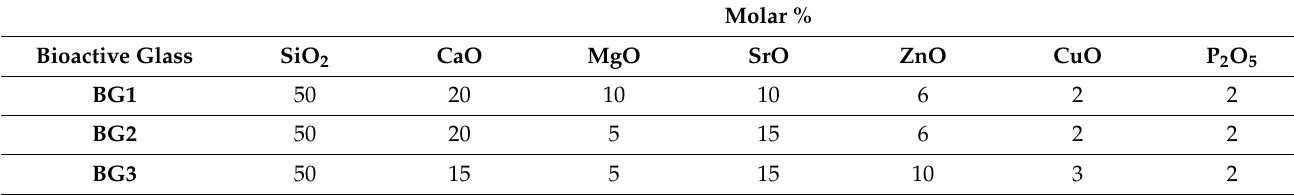
Table 1. Chemical compositions and nomenclature of the prepared bioactive